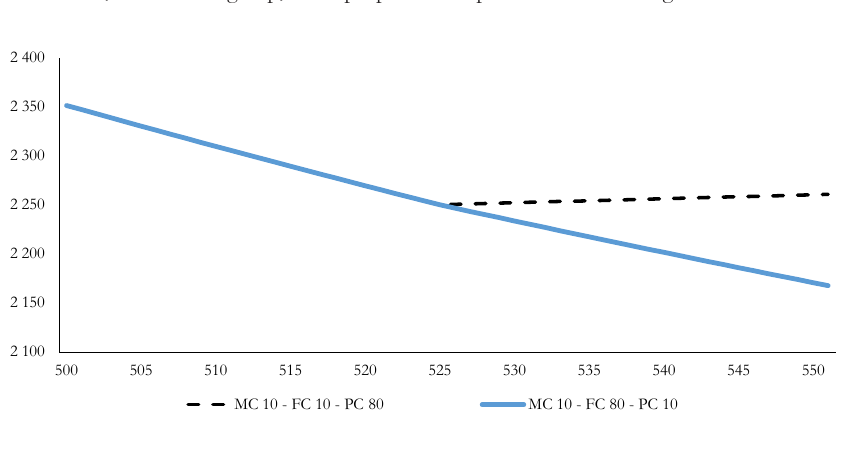
Fig. 3 – Supplier’s per-unit costs (model with overtime). Source: